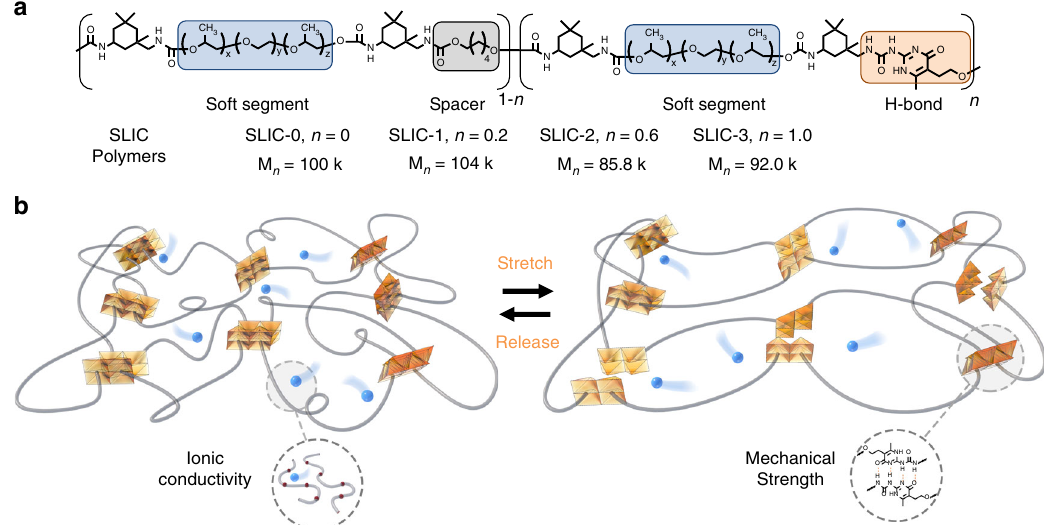
Fig. 1 Schematic of the SLIC macromolecules presented in this work. a Chemical structure of SLIC and the composition and molecular weight of SLIC-0 to SLIC-3. x = 9, y = 23, z = 9. b Diagram showing the general operating principle of a SLIC-based polymer electrolyte upon stretching. Blue circles represent lithium ions, black wires are PPG-PEG-PPG chains, and orange squares are hydrogen-bonding UPy moieties.